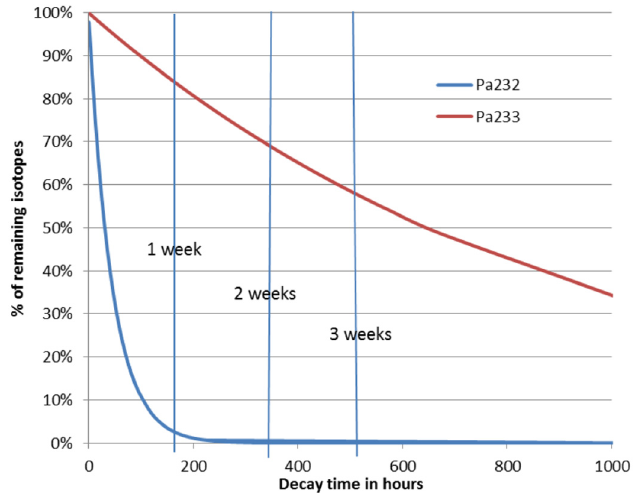
Fig. 5. Remaining Pa isotope fractions after Pa isolation. After 3 weeks of decay, the remaining fractions are 58% 233 Pa and 13 ppm 232 Pa (respectively 70% and 560 ppm after 2 weeks).